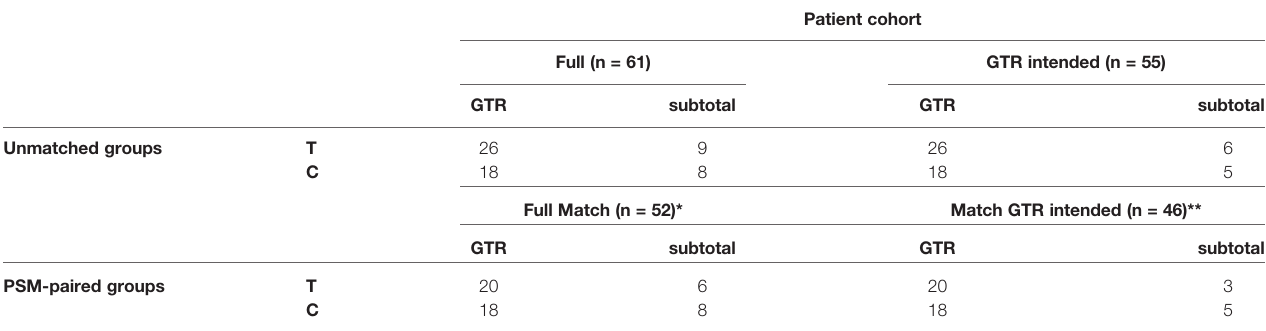
TABLE 4 | Contingency tables showing group-wise distribution of resection completeness.